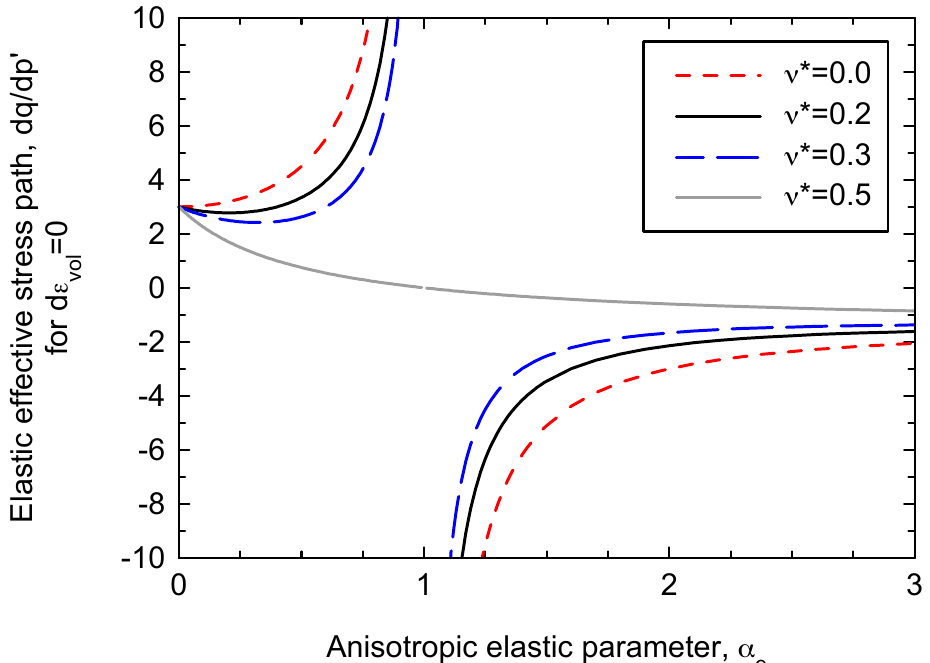
Figure 8. Elastic effective stress path for compression under constant volume ( d ε e v = 0).